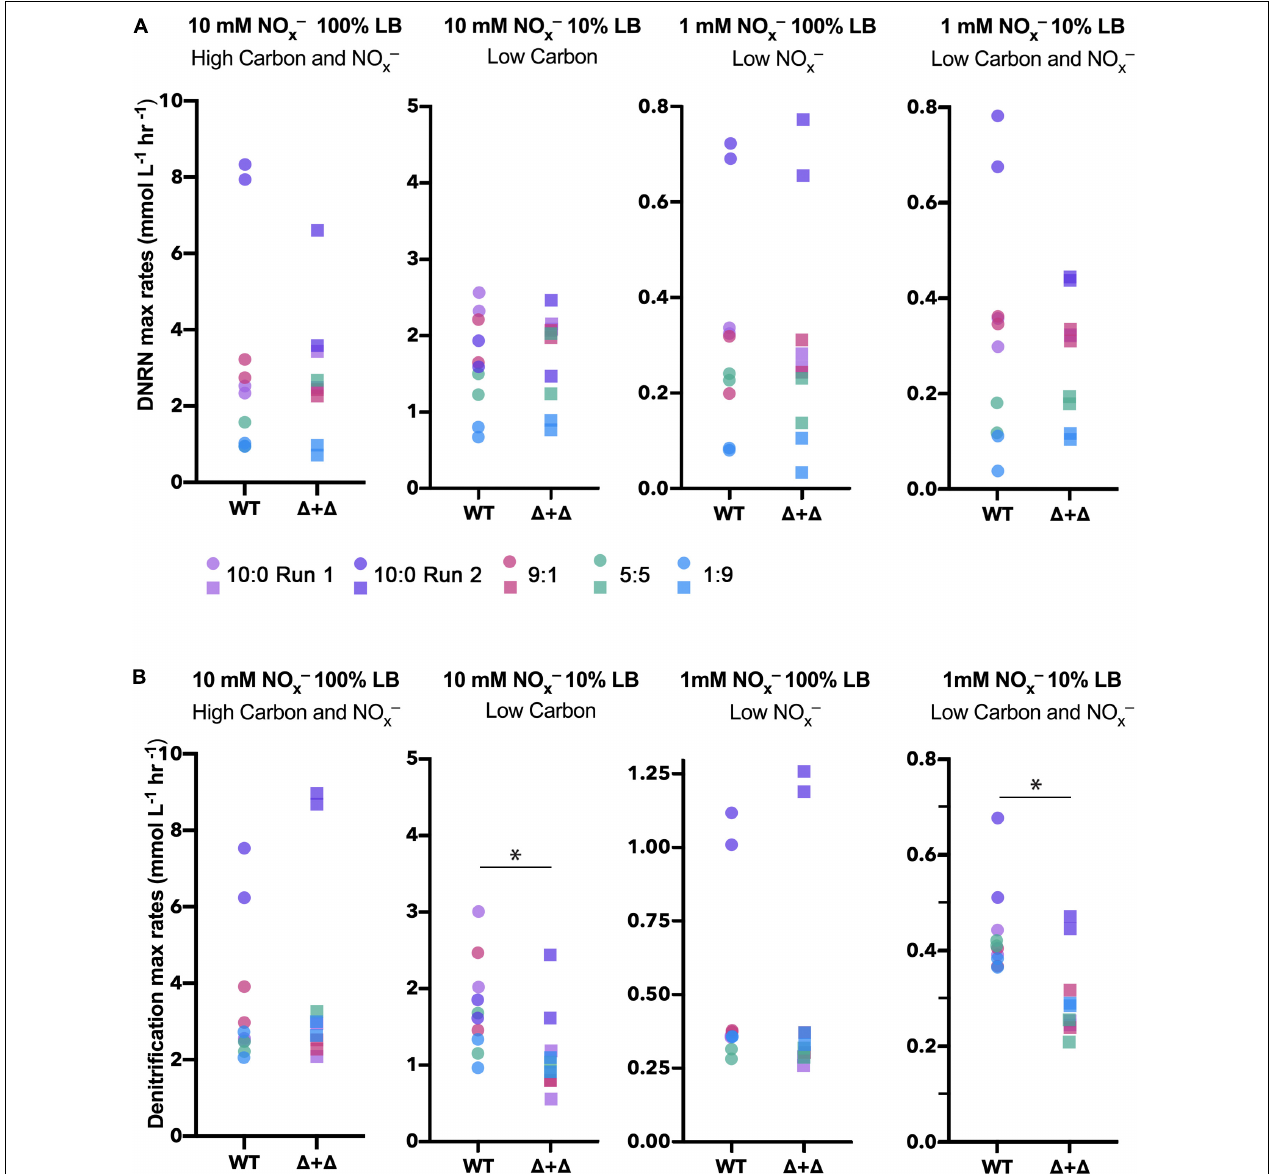
FIGURE 4 | Maximum DNRN and denitrification rates for WT and (cid:49) + (cid:49) cultures in LB. Maximum DNRN rates are plotted for each culture under each nutrient condition and colored by NO 3 − /NO 2 − ratio (10:0 run 1, lavender; 10:0 run 2, dark purple; 9:1, red; 5:5, green; 1:9, blue). For both WT and (cid:49) + (cid:49) , n = 4 for the 10:0 NO 3 − /NO 2 − ratio and n = 2 for the 9:1 and 5:5 ratio for each nutrient regime, and n = 10 for each nutrient regime including all depicted ratios. There is no significant difference in DNRN rates when comparing between WT or (cid:49) + (cid:49) for any treatment. DNRN rates are 10-fold higher under 10-fold higher NO x − , but are not influenced by carbon availability. (B) Maximum denitrification rates for cultures and conditions, as in panel (A) . For 10% LB regimes, denitrification rates decrease in (cid:49) + (cid:49) cultures, while there is no difference between denitrification rates when comparing cultures for 100% LB regimes. NO 3 − /NO 2 − ratios did not significantly affect denitrification